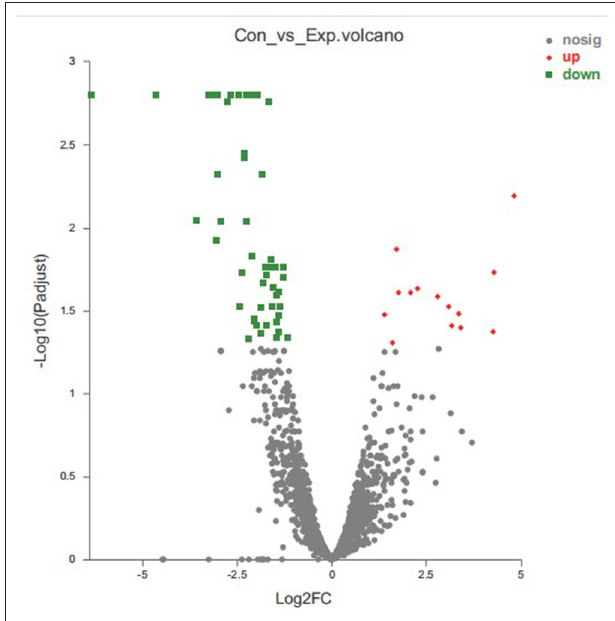
FIGURE 7 | Statistics of differentially expressed genes. X-axis: fold change value (FC) of gene expression difference between two groups of samples; Y-axis: p-adjust value. Each dots represents a specific gene in this figure: Red points: up-regulated genes (13); Green points: down-regulated genes (51); Gray points: non-significantly different